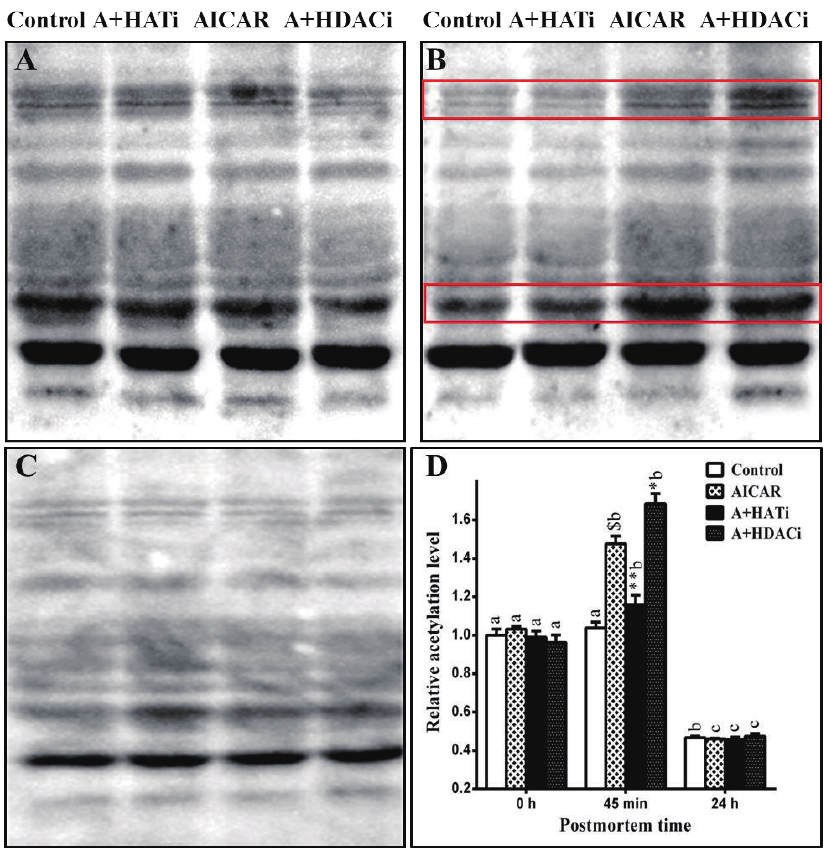
Figure 2 . Total acetylated proteins in postmortem muscles. (A)-(C) Immunoblots of total acetylated proteins in muscles collected at 0 h (A), 45 min (B), and 24 h (C) postmortem. (D) Quantification of acetylated proteins. AICAR, 5-Aminoimidazole-4-carboxamide1- β -D-ribofuranoside; A+HATi, AICAR plus histone acetyltransferase inhibitor II; A+HDACi, AICAR plus histone deacetylase inhibitors. $ p<0.001 compared with control group; * p<0.05 and ** p<0.01 compared with AICAR-injected group. abc Means that there was significant difference among time points within the same group. n = 8.